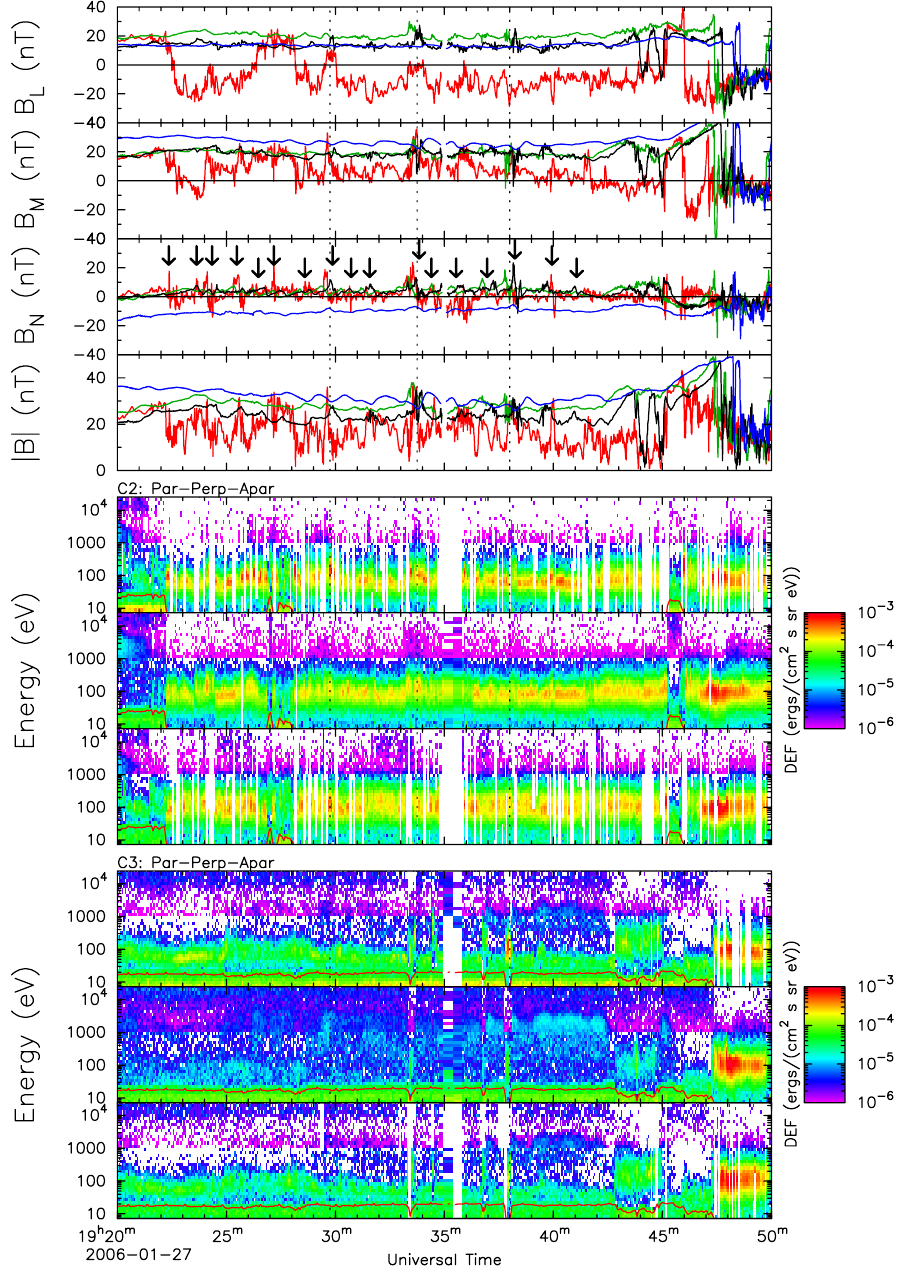
Fig. 5. FTE signatures observed by Cluster. The top four panels show the magnetic field observed by the four Cluster spacecraft in boundary normal coordinates. Many bipolar B N signatures are evident in the data from Cluster 2 (red trace), whilst Cluster 2 was in the magnetosheath (as evidenced by a negative B L component). Several of these signatures are also observed by Clusters 1 and 3 (black and green), and three FTEs also have weak counterparts which are observed at Cluster 4 (blue trace). Arrows indicate FTEs observed by at least one spacecraft, and vertical dotted lines indicate FTEs which were observed by all four spacecraft. The middle three panels show electron spectrograms from the PEACE instrument onboard Cluster 2. They show the differential energy flux of electrons moving parallel/perpendicular/antiparallel to the magnetic field. The spacecraft potential is indicated by a red line; electrons at energies below this trace are due to photoionisation of the spacecraft, and do not form part of the natural plasma environment. Accelerated magnetosheath-energy electrons are observed which coincide with the FTE signatures. The bottom three panels follow the same format, but show PEACE data from Cluster 3, which was situated in the magnetosphere. Several transient, field-aligned bursts of magnetosheath energy electrons are